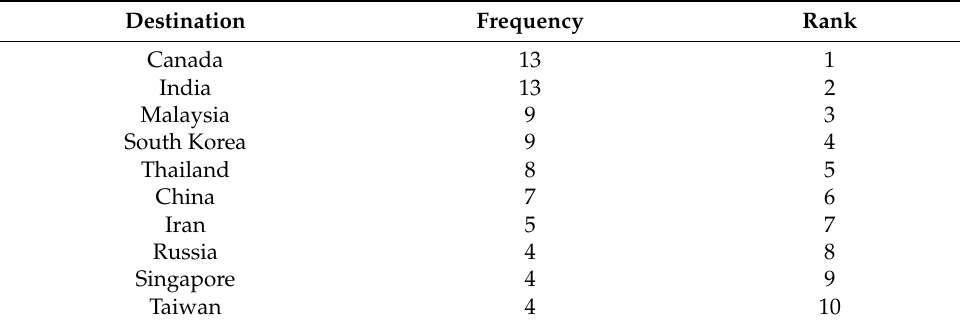
Table 3. Medical-health-wellness destination frequency in